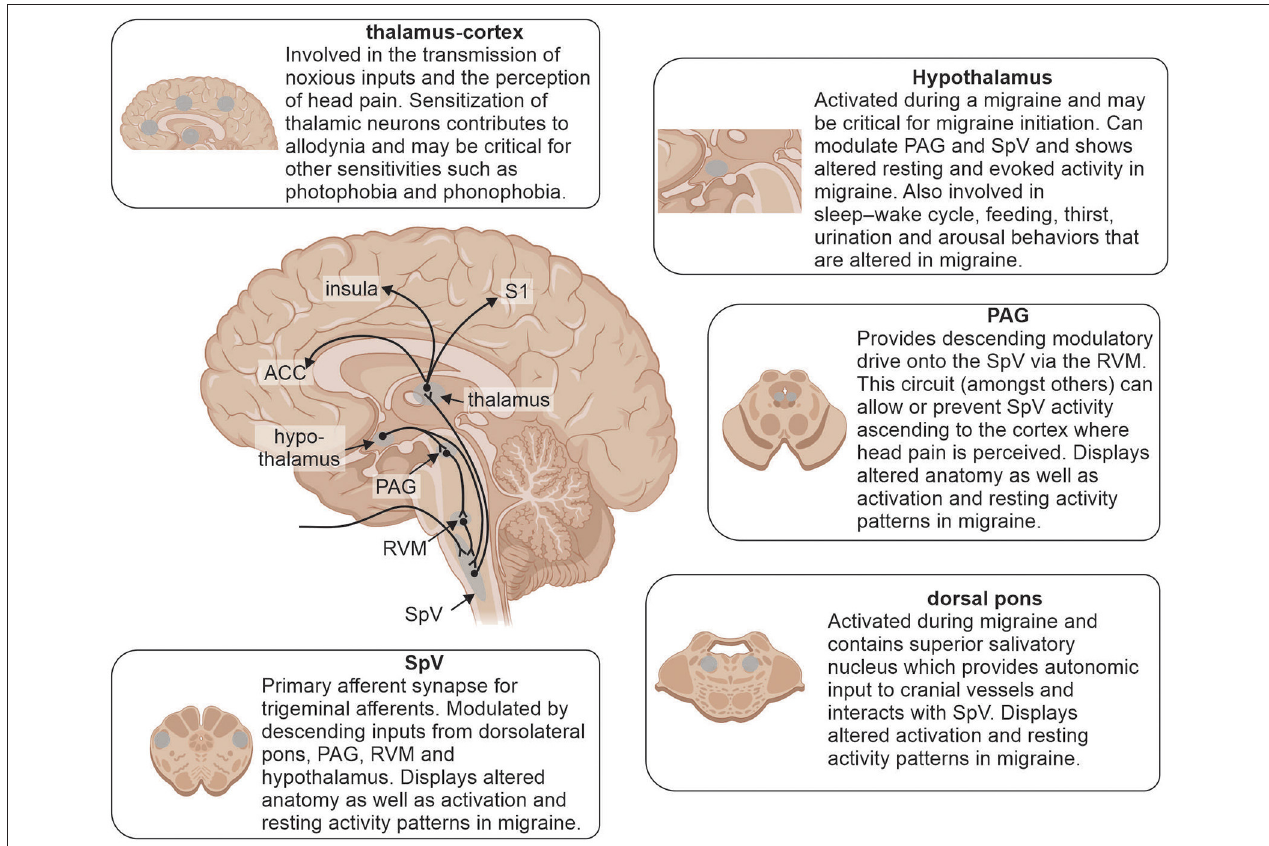
FIGURE 3 | Brain regions involved in underlying mechanisms of migraine and reported alterations. Modulation of incoming noxious inputs: spinal trigeminal nucleus (SpV), periaqueductal gray matter (PAG), rostral ventromedial medulla (RVM) and dorsal pons. Higher order processing: hypothalamus, thalamus, anterior cingulate cortex (ACC), insula and primary somatosensory cortex